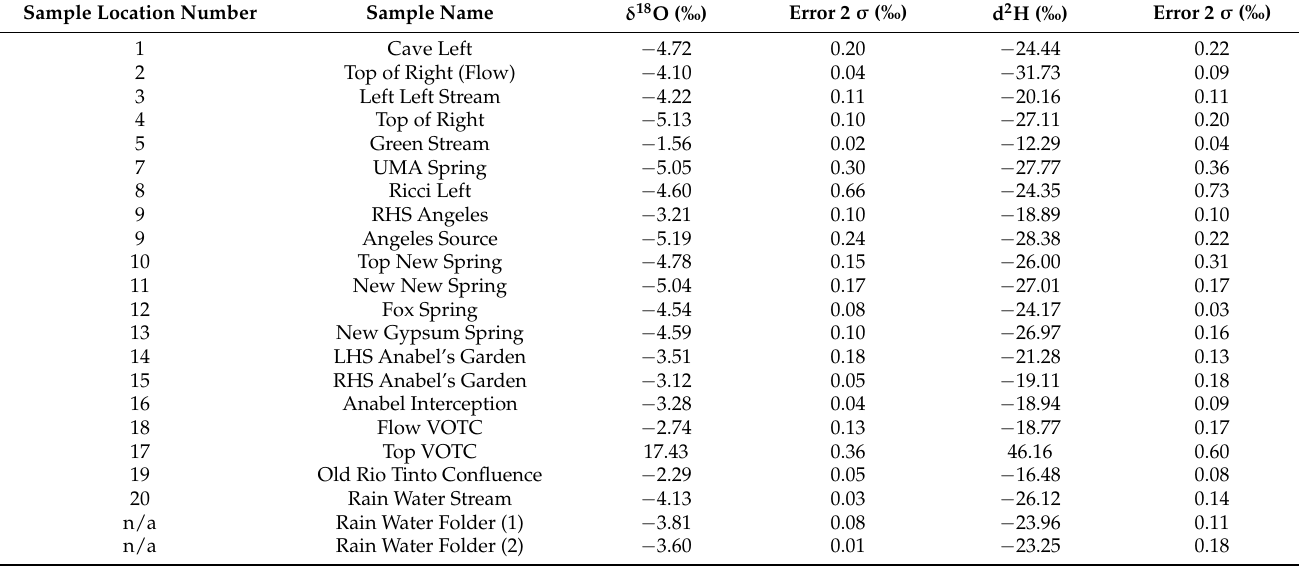
Table 3. Table summarizing the measured oxygen 18 and deuterium isotopic values on the Picarro L2130-I isotope analyzer situated at The Scottish Association for Marine Science. Each of the values have two standard error values for each locality. Samples were measured using a Picarro L2130-I isotope analyzer (Santa Clara, CA, USA). Each sample was measured 9 times (over 1.5 h) with the first six results ignored due to the potential memory effect of the previous sample. The remaining three results are reported as a mean ratio and an error expressed as two times the standard deviation of the three analysis. Raw isotope ratios were converted delta notation relative to V-SMOW (2) by using certified reference material IA-RO52, IA-RO53 and IA-RO54.